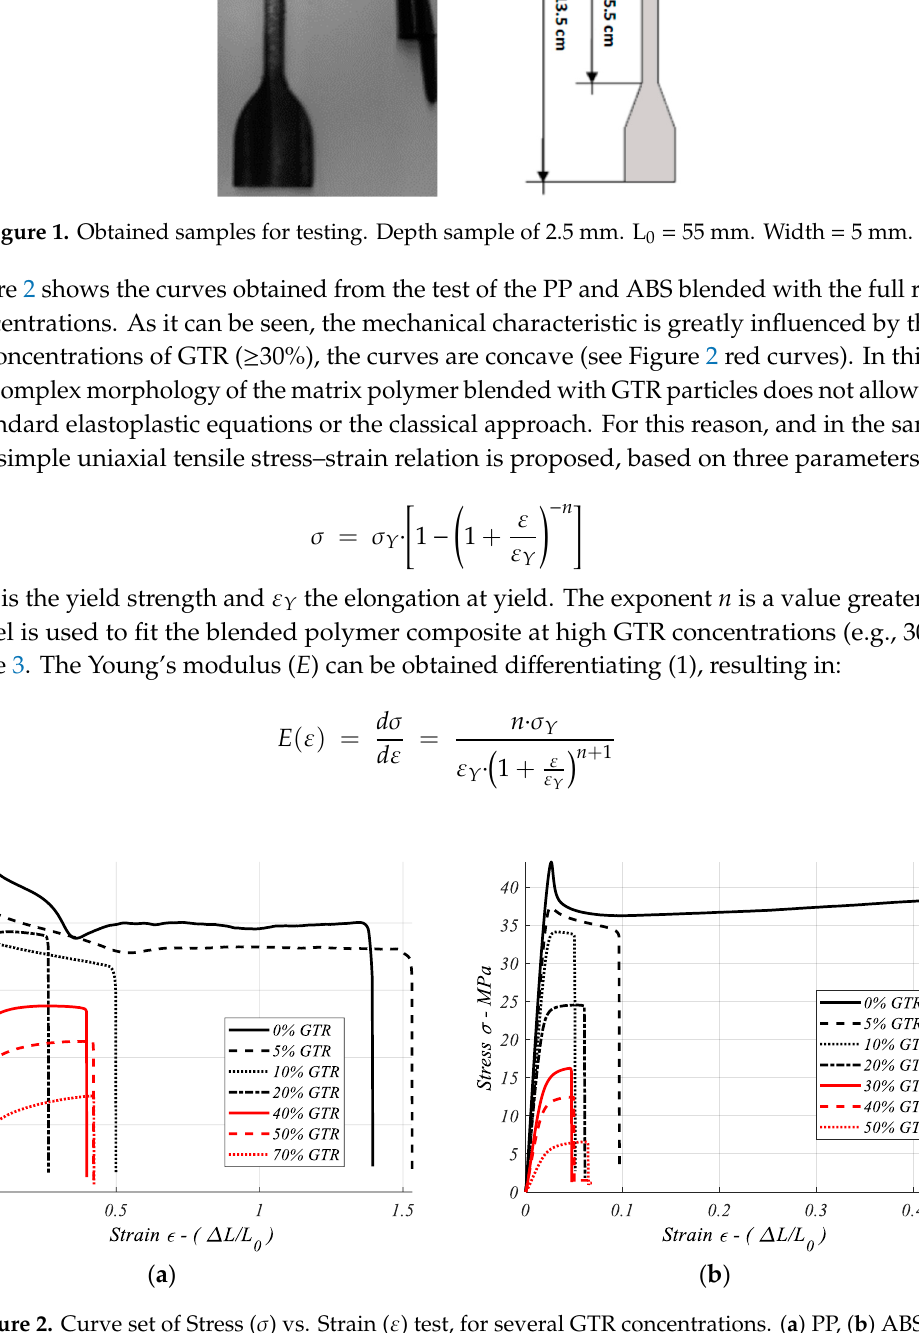
Figure 1. Obtained samples for testing. Depth sample of 2.5 mm. L 0 = 55 mm. Width = 5 mm.